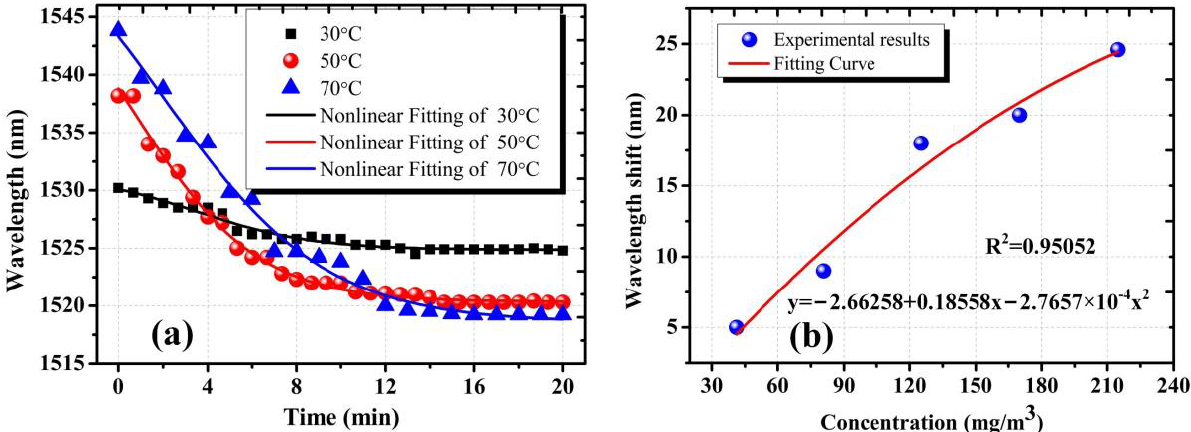
Figure 5. ( a ) The wavelength dips shift for the proposed sensors with 3.0  m diameter as measure- ment time elapsed at 30 °C, 50 °Cand 70 °C; ( b ) the relationship between wavelength shift and AMCs ment time elapsed at 30 ◦ C, 50 ◦ C and 70 ◦ C; ( b ) the relationship between wavelength shift and concentration for the as-fabrication sensors with 3.0 μ m diameter. AMCs concentration for the as-fabrication sensors with 3.0 µ m